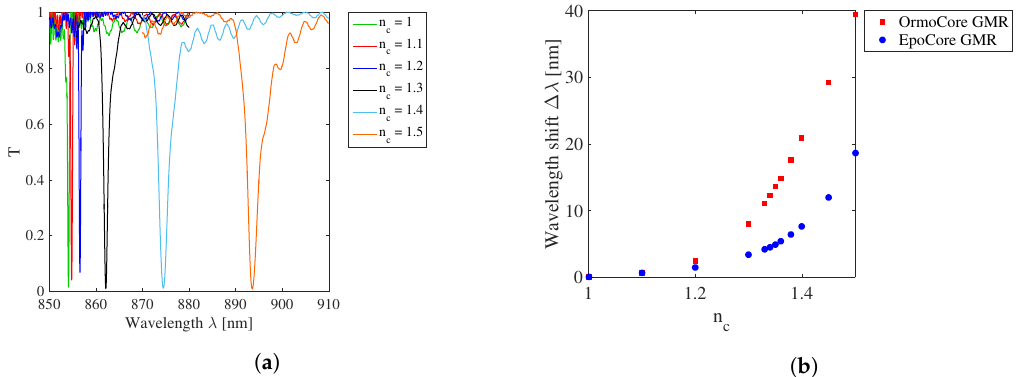
Figure 11. ( a ) Simulated transmission spectra for different RIs of the surrounding medium n c for the GMR grating in OrmoCore. ( b ) The simulated resonant wavelength shift ∆ λ as a function of the RI of the surrounding medium n c for the GMR grating in OrmoCore and EpoCore. The used grating parameters are listed in Table